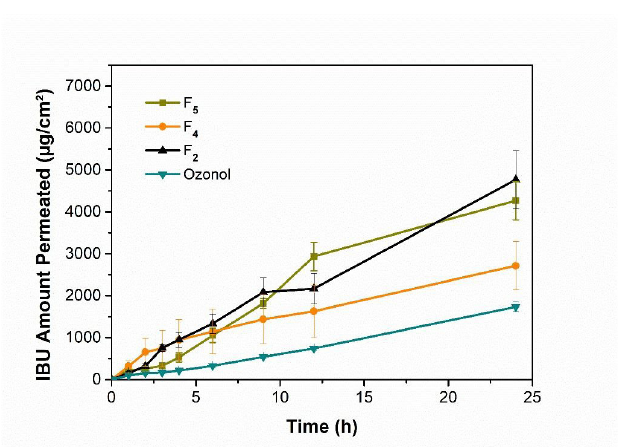
FIGURE 4 - In vitro permeation profiles of patches formulations with the best adhesives. The results are expressed as mean ± SEM (n=6).